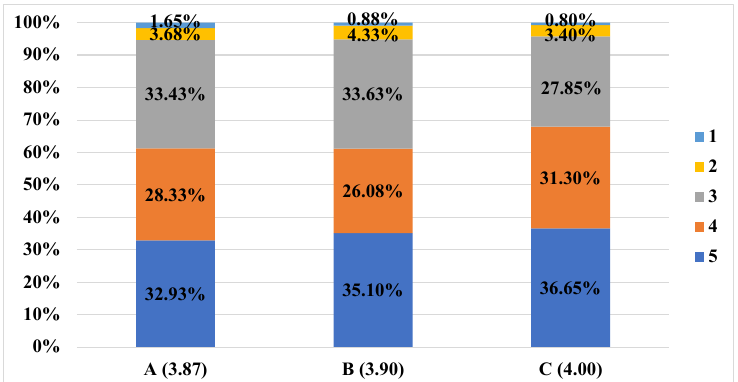
Figure 4. Results of the manual evaluation (Japanese → Chinese).